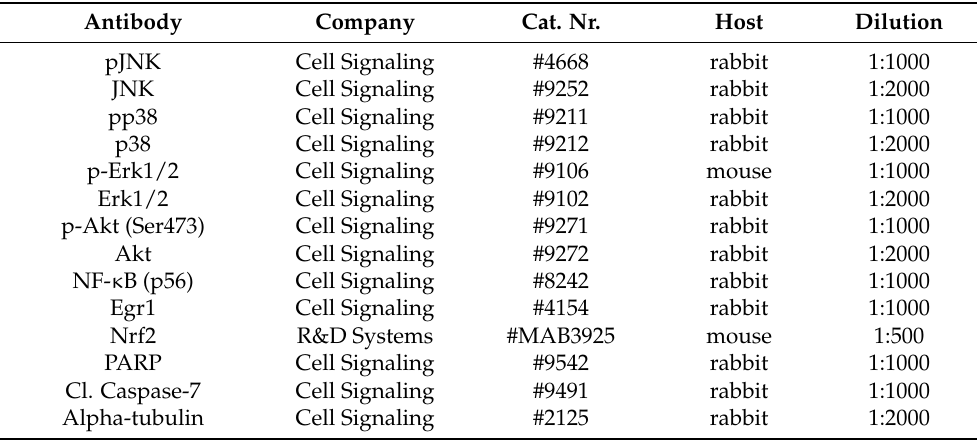
Table 1. Primary antibodies and dilutions used in this